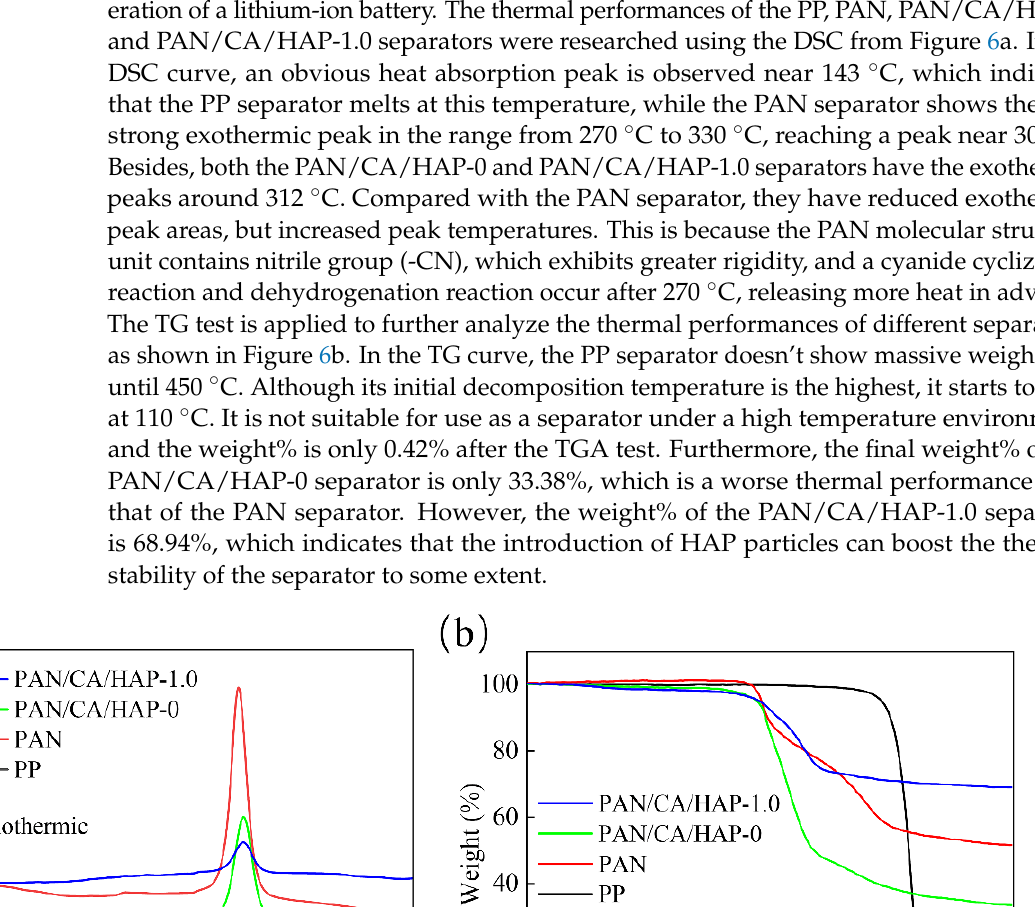
Figure 7. Thermal shrinkage behaviors of the separators after heat treatment at different tempera- tures for 35 min. 3.7. Contact Angle Analysis The transient contact angles of different separators with electrolyte are shown in Fig- ure 8 to further research the wettability of separators. The contact angle of the PP separator is the largest at 52.5°, indicating that it has the worst electrolyte compatibility, while the PAN separator has a contact angle of 37.1°, whose electrolyte wettability will be better